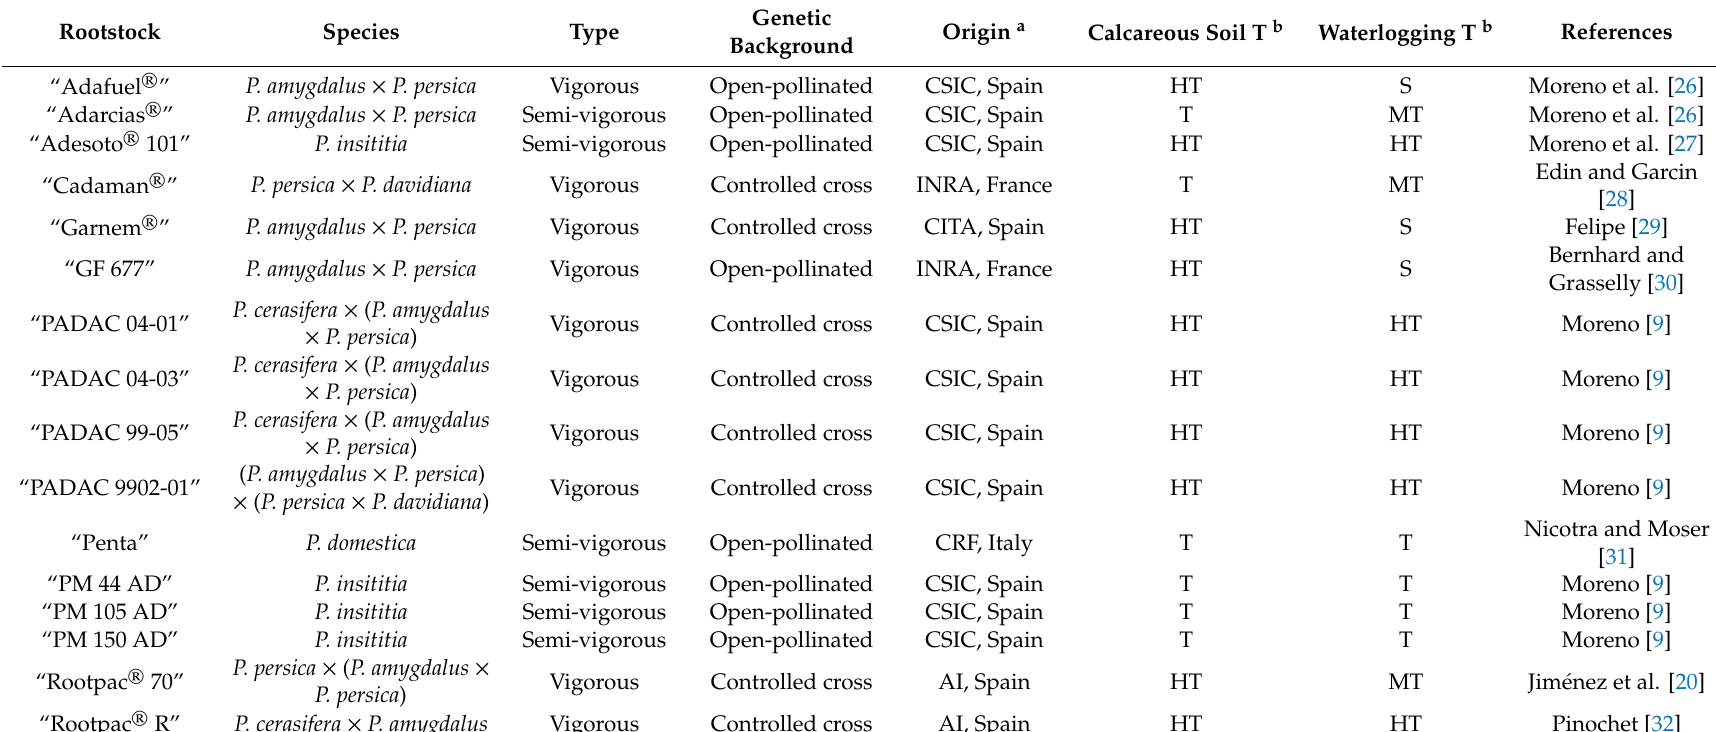
Table 1. List of evaluated rootstocks in this study, description and